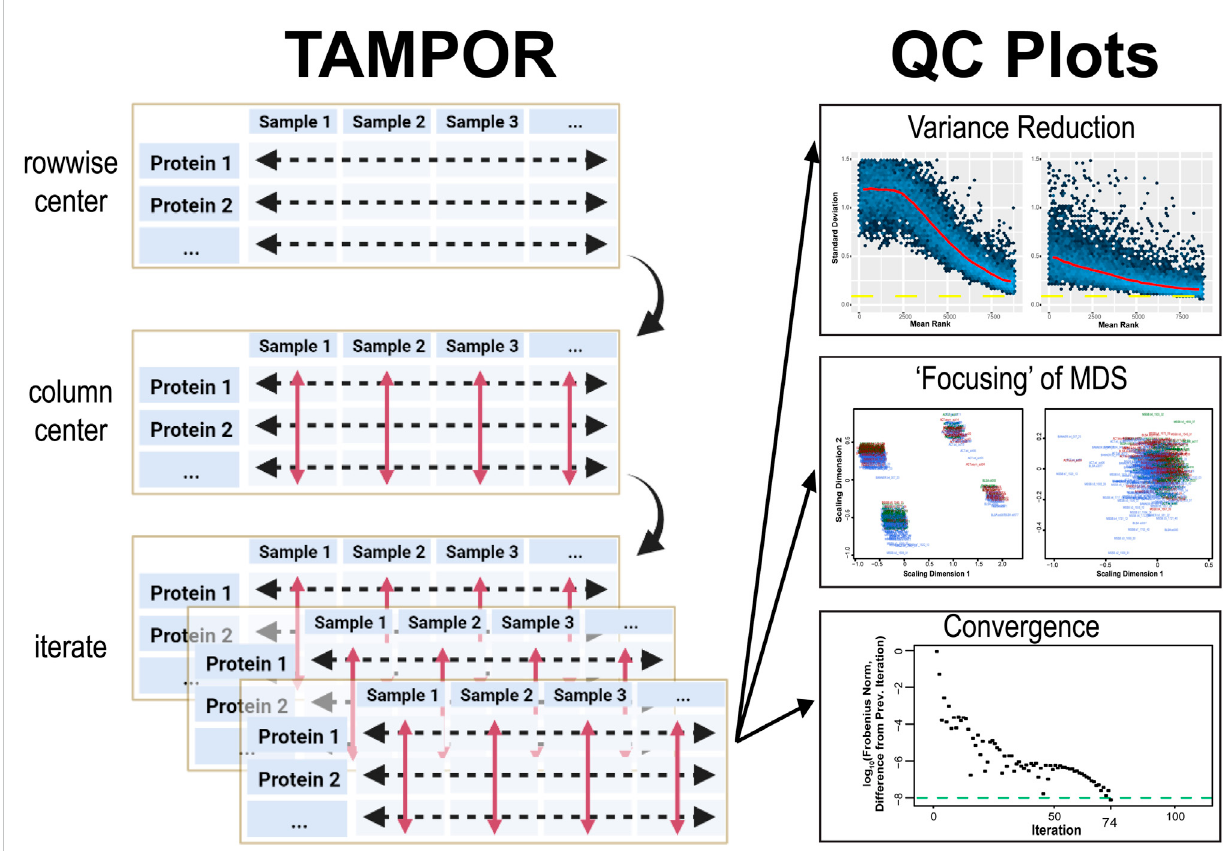
TAMPOR for median polish of abundanceand quality control (QC) visualization ofcorrection ofbatch effect. Left , TAMPOR algorithm implementsa 2-stepmedianpolish, fi rstcalculatingaratioforeachabundancevalueusingatwo-termequationoperatingonrowstobringthedataindifferentbatches towardsacommondenominator ( “ row-wise centering ” ). Then, log 2 (ratio)data arecenteredatamedian valueof0(redarrows, “ columncentering ” ).The initialmedianabundanceofarowisthenmultipliedbyallantiloggedratioswithinthatrow,thisisrepeatedforallrowstoreproducedatainthesame formatasinput,andthe2-waymediancenteringprocessisiterateduntilconvergence. Right ,visualizationofqualitycontrolisperformedin3waysbythe TAMPORfunctioninR.Mean-standarddeviation(mean-SD)plotsshouldshowareductioninoverallvariancefortheentirepopulationofproteinsranked bytheirmeanabundance,fromhightolow.Multidimensionalscaling(MDS)plotsshowafocusing ofvariance frommultiplefocirepresentingbatches,to asinglefocus,indicatingresolutionofthebatcheffect.Last,theconvergencecriterion,differenceinFrobeniusnorm,istrackedoversuccessiveiterations of the algorithm. The algorithm by default runs for up to 250 iterations, or until convergence is reached (a difference in the Frobenius norm from the previous iteration of < 10 – 8